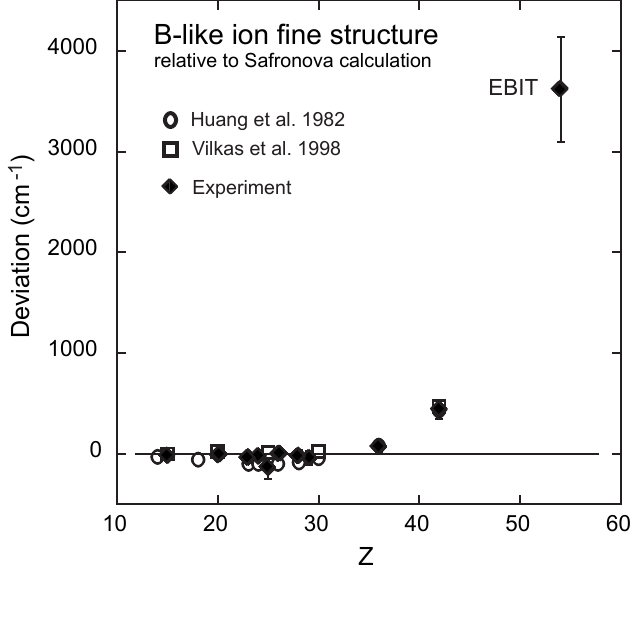
Figure 6. The 2s 2 2p 2 P o J = 1 / 2 - J = 3 / 2 ground state fine structure splitting in B-like ions, shown as the deviation from the computations by Safronova et al. [138]. Up to about Z = 30 , experiment (filled symbols) and other computations (open symbols) stay close to the trend predicted by Safronova et al. , but then they diverge. Unfortunately, in the latter range the accurate computations are extremely sparse. The EBIT data point for